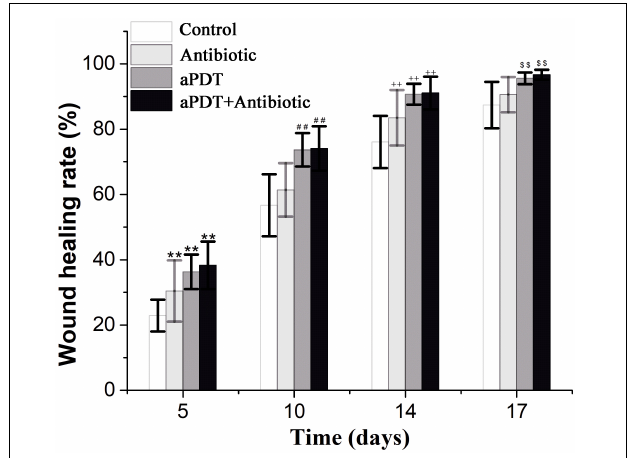
FIGURE 7 | Wound healing rate of each group on the 5th, 10th, 14th, and 17th day post-infection [* p < 0.05, ** p < 0.01 vs. control group (5 days); # p < 0.05, ## p < 0.01 vs. control group (10 days); + p < 0.05, ++ p < 0.01 vs.